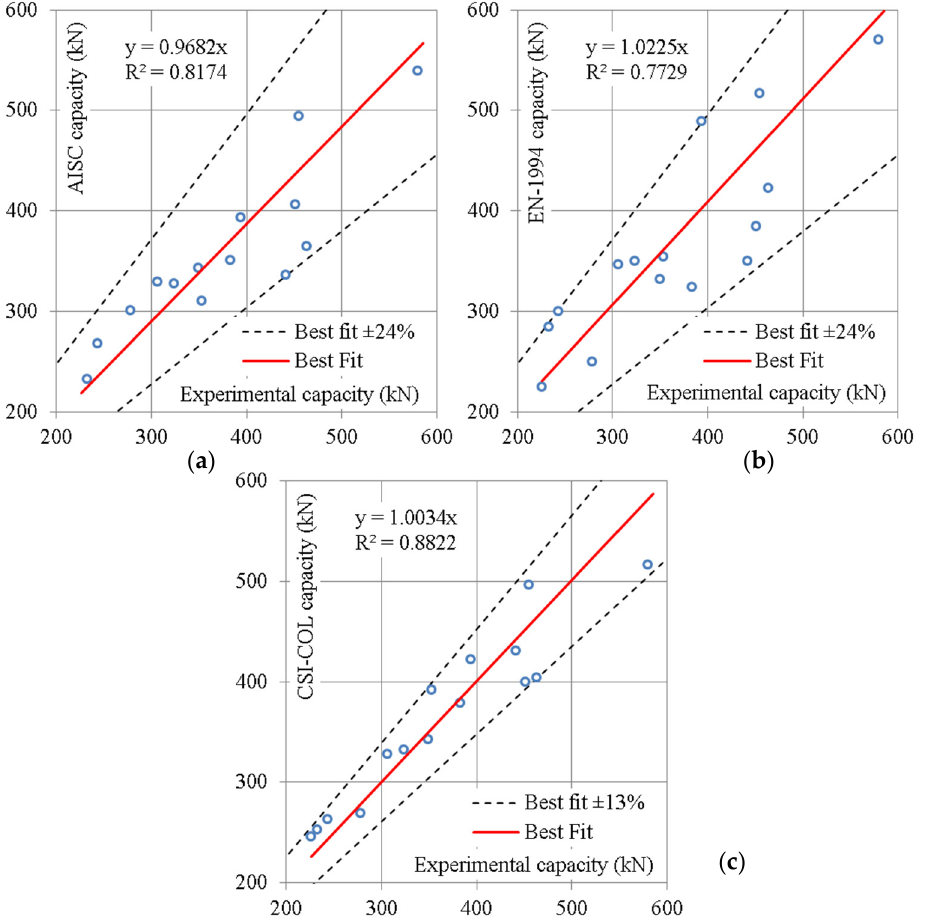
Figure 9. Comparison between both experimental and theoretical capacities. ( a ) Using AISC-LRFD, ( b ) Using EN-1994, ( c ) Using CSI-COL software.